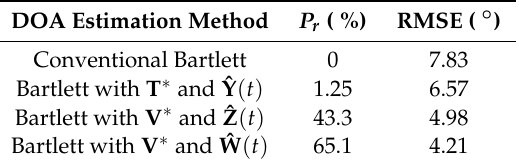
Figure 13. Measurement environment of two target vehicles (expressway). Table 3. Resolution probabilities and root mean squared errors for two target vehicles